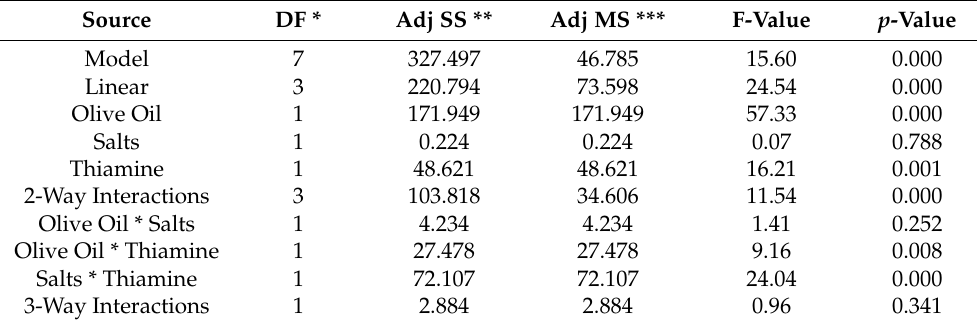
Table 3. Analysis of variance calculated by Minitab 19 for the factorial